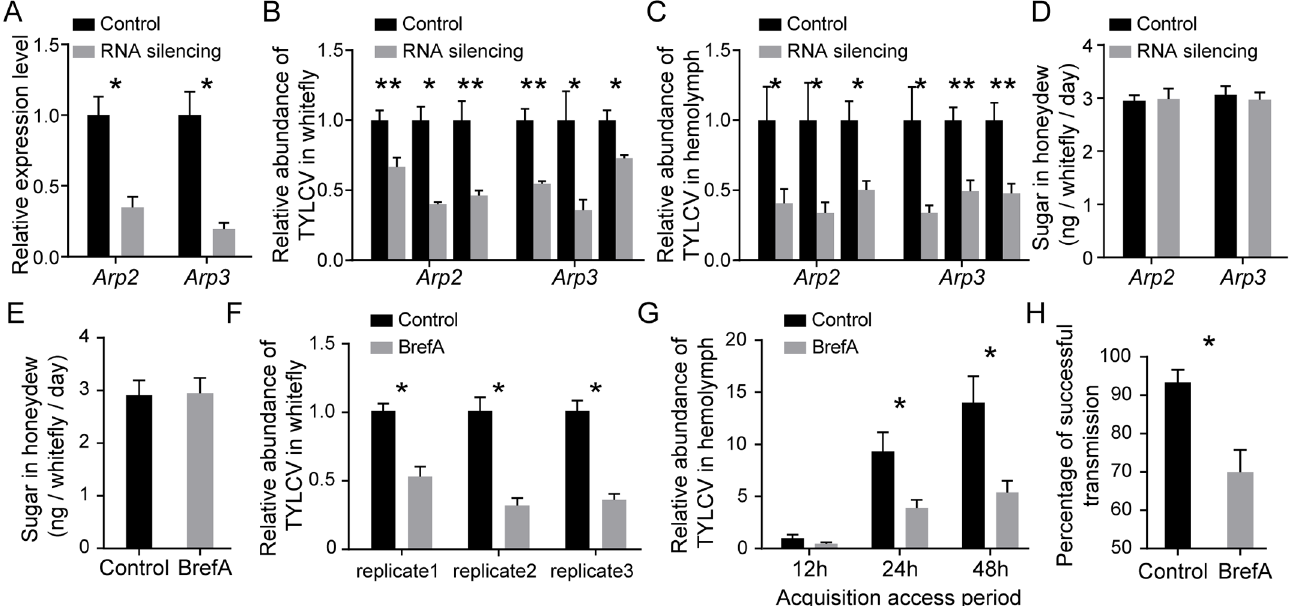
Fig 1. Inhibiting TYLCV acquisition by disrupting vesicle traffic. (A-C) Silencing of Arp 2 and Arp3 . Genes were silenced by injecting dsRNA into hemolymph of whitefly. Whiteflies injected with dsRNA of GFP were included as a control. The insects were then kept on cotton plants. (A) Seventy-two hours after dsRNA injection, gene expression levels were measured by quantitative RT-PCR (n = 4–5, n represents the number of samples). (B-C) The effect of the Arp2/3 complex on virus acquisition. Seventy-two hours after dsRNA injection, the treatment group and its control group were caged on two symmetrical leaves of the same TYLCV- infected plants. The abundance of virus in the whitefly whole body (B) and hemolymph (C) was measured after a 48 h acquisition access period (AAP) by quantitative PCR and compared with that in controls injected with dsRNA of GFP (for the whole body of whitefly, n = 4–8; for hemolymph, n = 8–24). (D-E) The quantity of honeydew excreted by whitefly. After RNA silencing or inhibitor feeding and 48 h AAP on tomato plant, the honeydew of whiteflies was collected from the surface of leaves and micro-cages and the content of sugar per whitefly per day was quantified (n = 5). (F) Effect of BrefA on virus acquisition. Whiteflies were fed with BrefA for 24 h and kept on TYLCV-infected plants for 48 h. Then, the abundance of virus in the whitefly whole body was measured by quantitative PCR and compared with that in ethanol-fed controls (n = 4). (G) Whiteflies were allowed to feed on TYLCV-infected plants for various AAP after feeding with BrefA or solvent ethanol. The abundance of virus in hemolymph was measured by quantitative PCR (n = 8–11). (H) Effect of BrefA on virus transmission. Whiteflies were first fed with BrefA and then transferred to TYLCV-infected plants for 12 h AAP. Next, the whiteflies were allowed to feed on tomato seedlings for 48 h and then removed. Percentages of tomato plants infected by the virus were calculated (n = 30). Data shown are mean ± SE. Statistically significant differences are indicated as (cid:3) , P < 0.05; (cid:3)(cid:3) , P < 0.01.